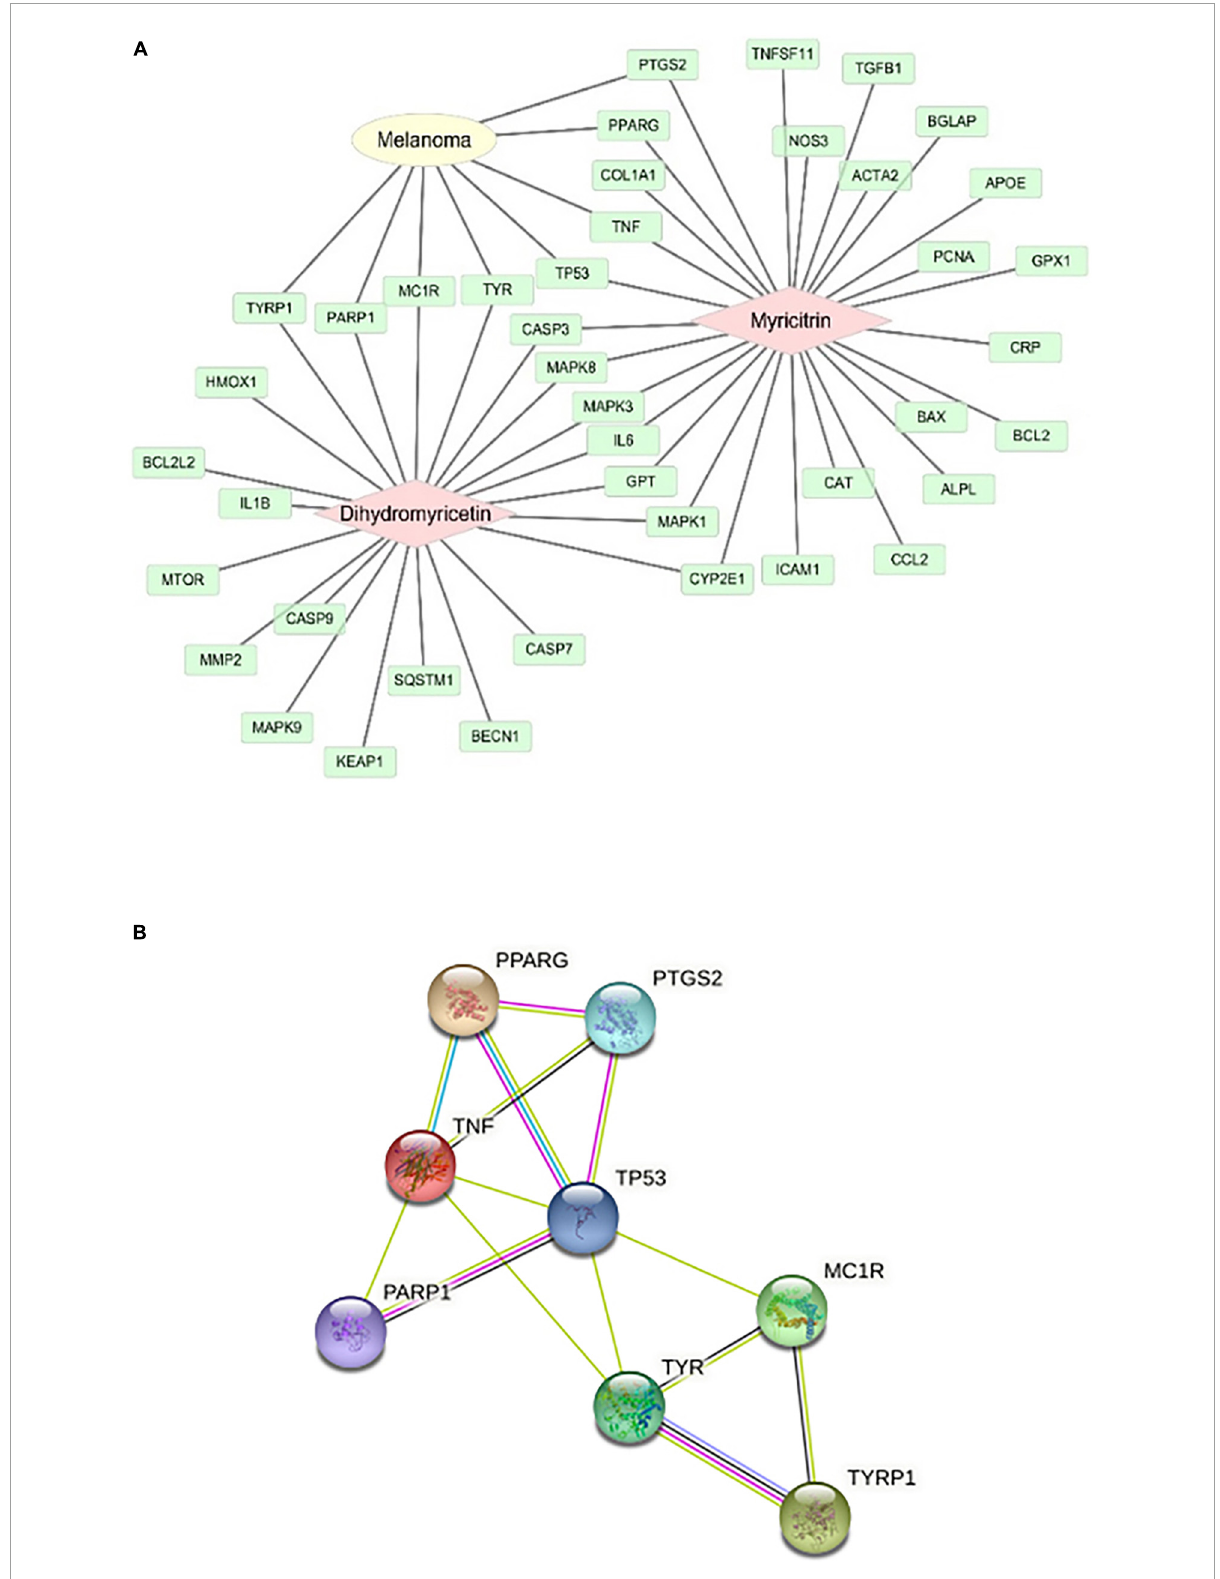
FIGURE9 Analysis of action targets of DMY and MYT on melanoma. (A) The targets of dihydromyricetin and myricitrin on melanoma. (B) The protein-protein interaction network of DMY, MYT, and melanoma disease.